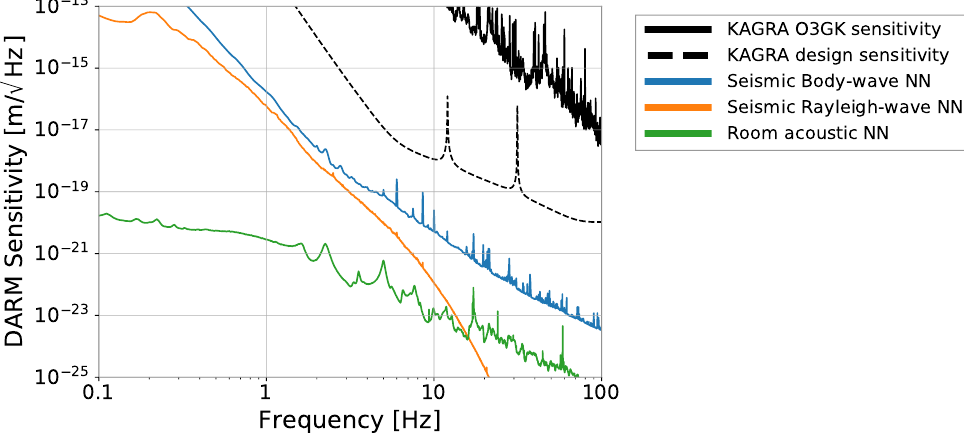
Figure 12. The estimated Newtonian noise from the seismic body waves (blue), seismic Rayleigh waves (orange), and acoustic fields in the experimental site (green) for KAGRA [46] compared with the O3GK sensitivity (black, solid) and design sensitivity (black, dashed) [37] of